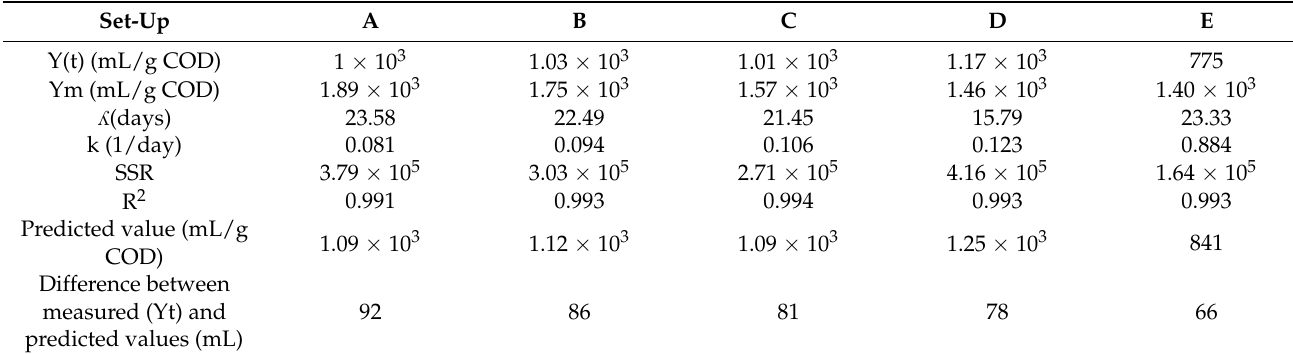
Table 6. Summary of the modified Gompertz kinetic models for bioreactors A–E.